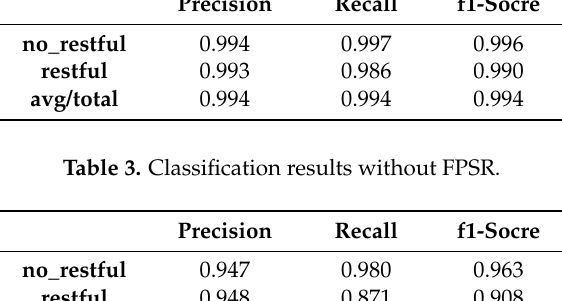
Table 2. Classification results using FPSR.